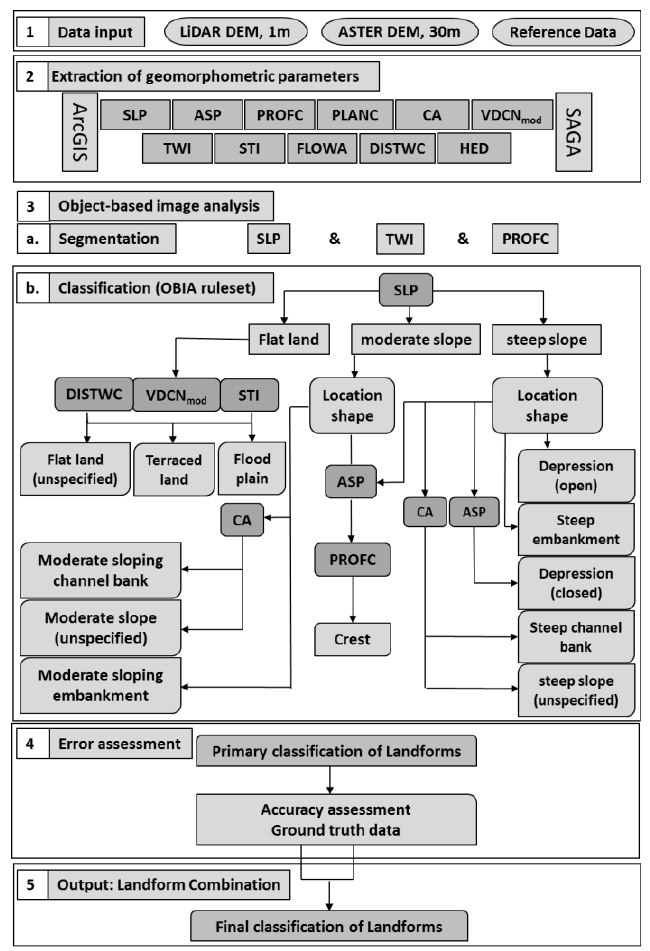
Figure 3. Flow chart of the methodology followed for the landforms classification in the study area in ArcGIS and SAGA GIS. Table 2. Geomorphometric parameters of the study area calculated from the LiDAR-DEM, ASTER-DEM and related data, which represent the input layers for a knowledge-based fuzzy landforms classification.